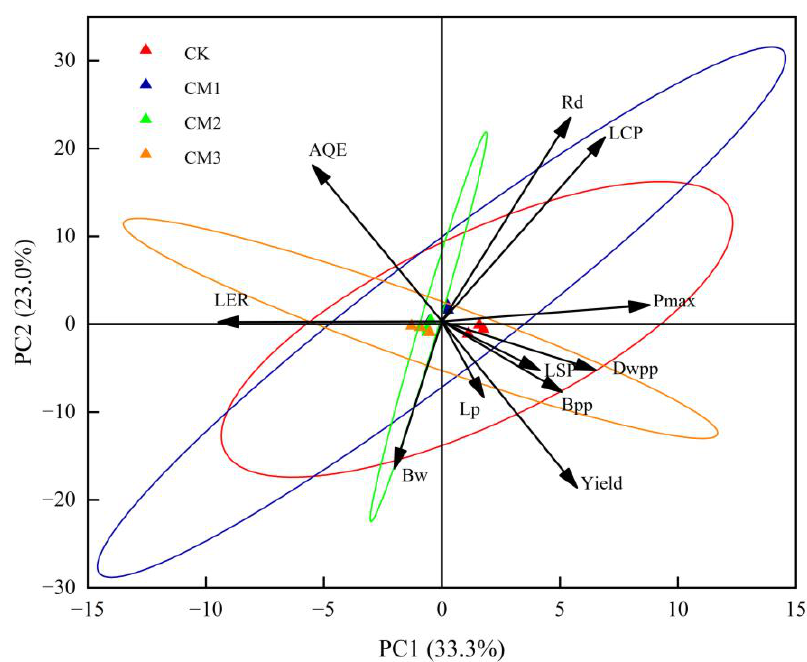
Figure 12. Principal component analysis for different configuration treatments. LSP: light saturation point; LCP: light compensation point; Pmax: the maximum net photosynthetic rate; AQE: apparent quantum efficiency; Rd: dark respiration rate; LER: the land equivalent ratio; Bw: single boll weight; Lp: lint percentage; Bpp: boll number per plant; Dwpp: dry weight per plant.